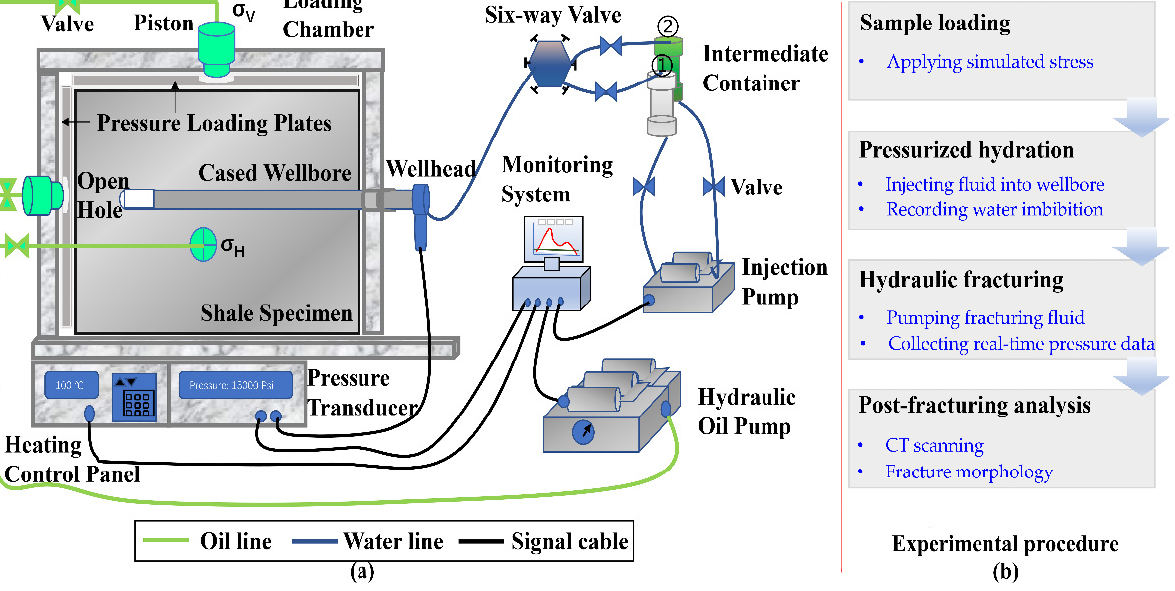
Figure 3. ( a ) Schematic diagram of the small size true triaxial hydraulic fracturing simulation device and ( b ) flowchart of the experiment. and ( b ) flowchart of the